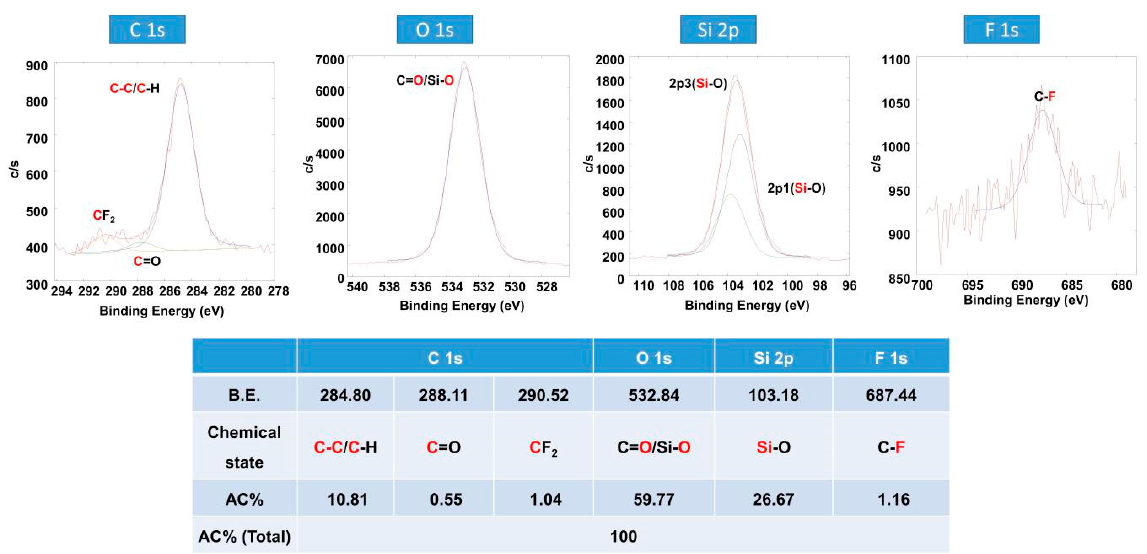
Figure 6. X-ray photoelectron spectroscopy (XPS) spectra with high resolution of four chemical states in Point 1: C 1s, O 1s, Si 2p, F 1s, and atomic concentration (AC%) of four chemical states in one sampling area.